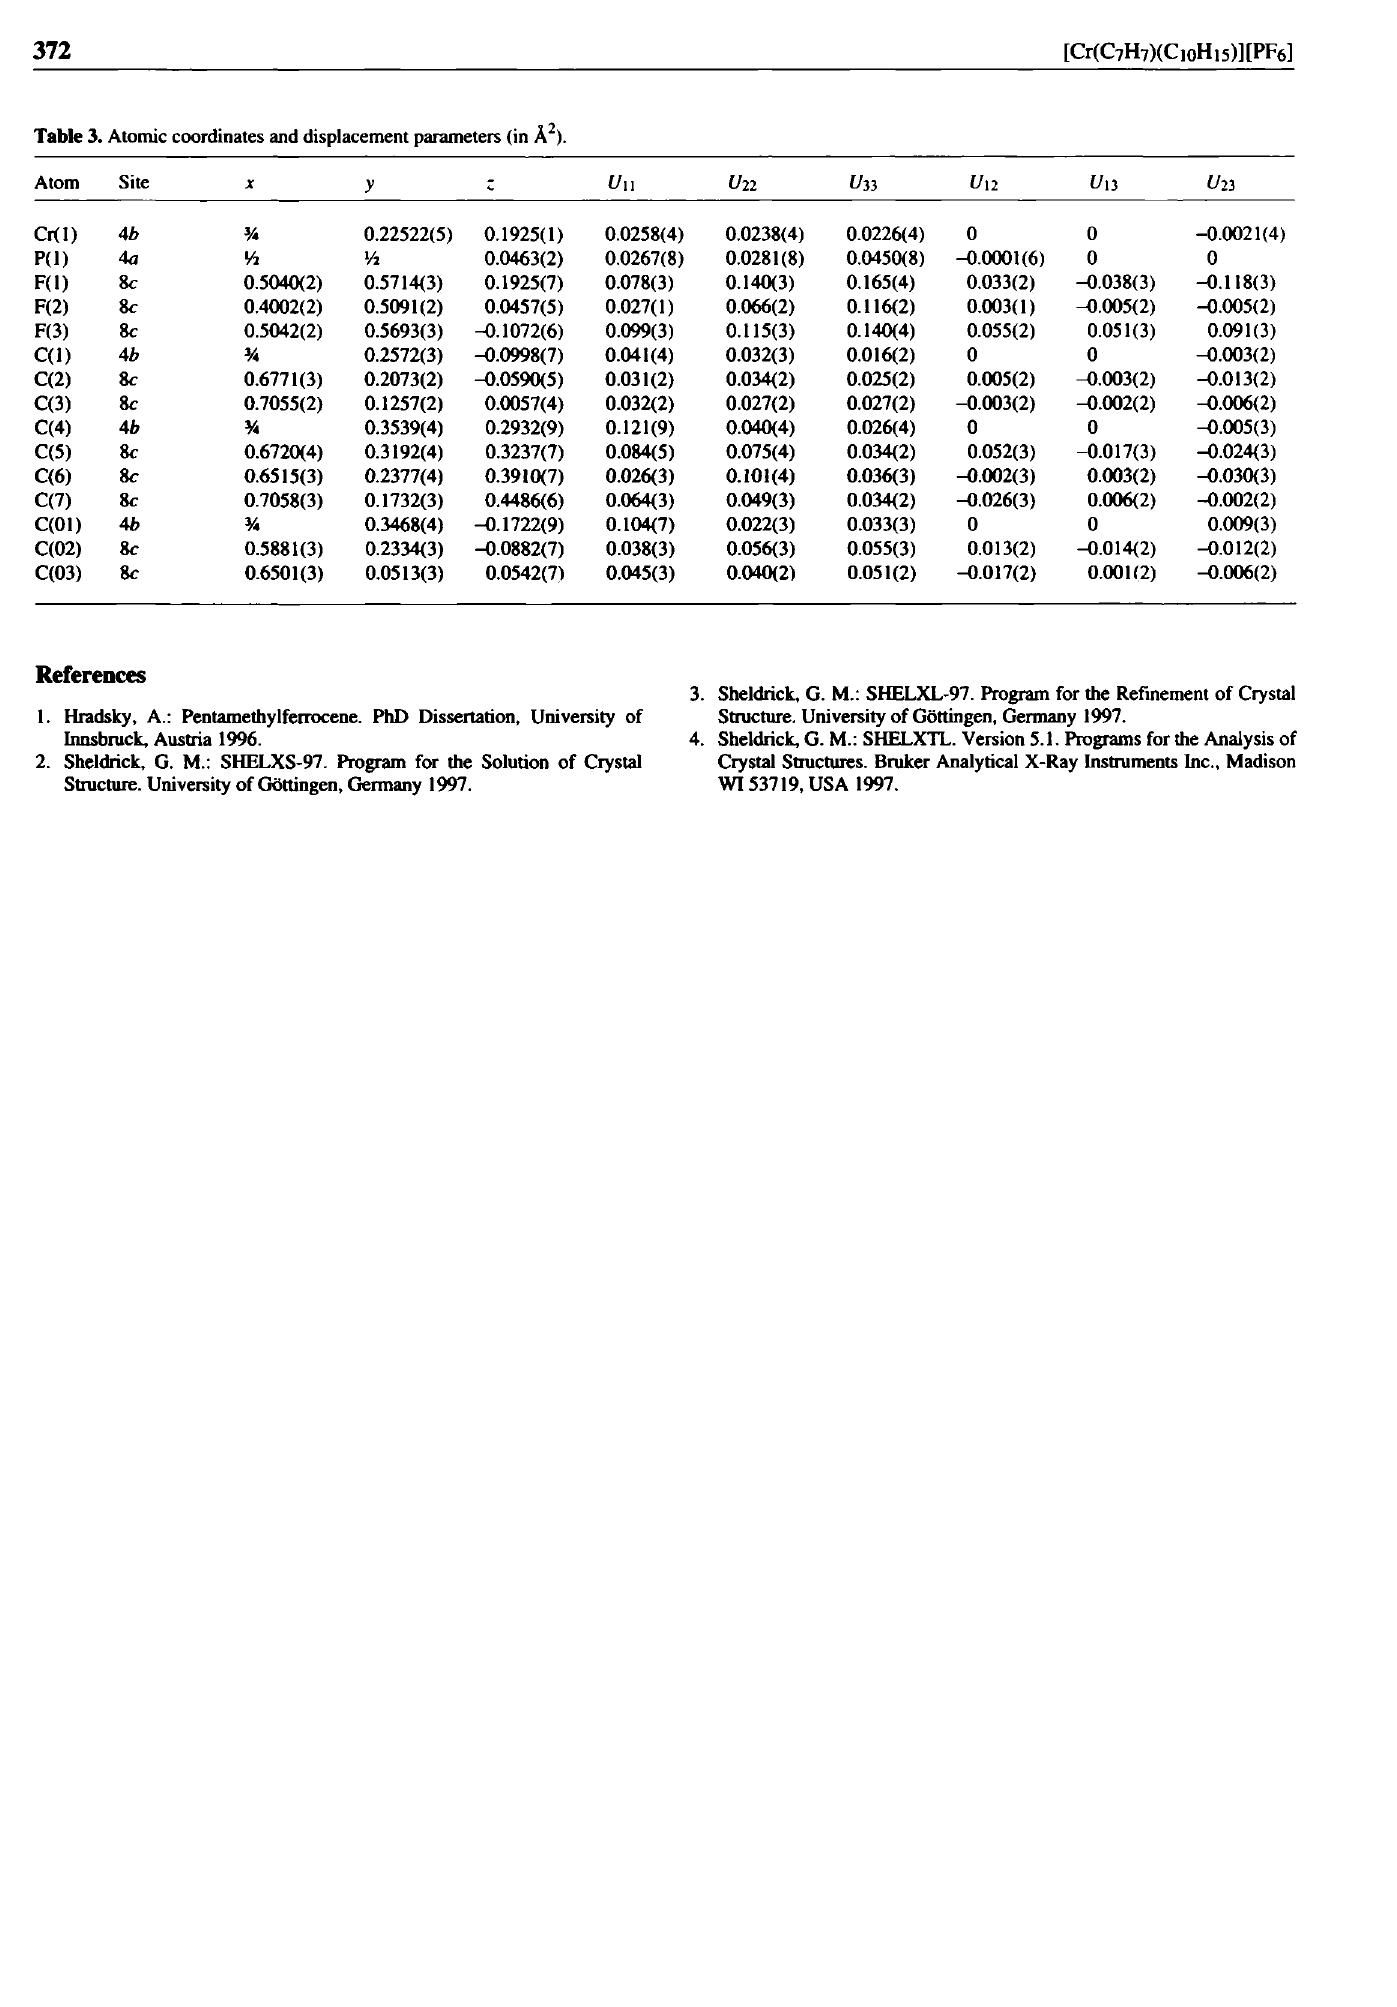
Table 3. Atomic coordinates and displacement parameters (in À 2